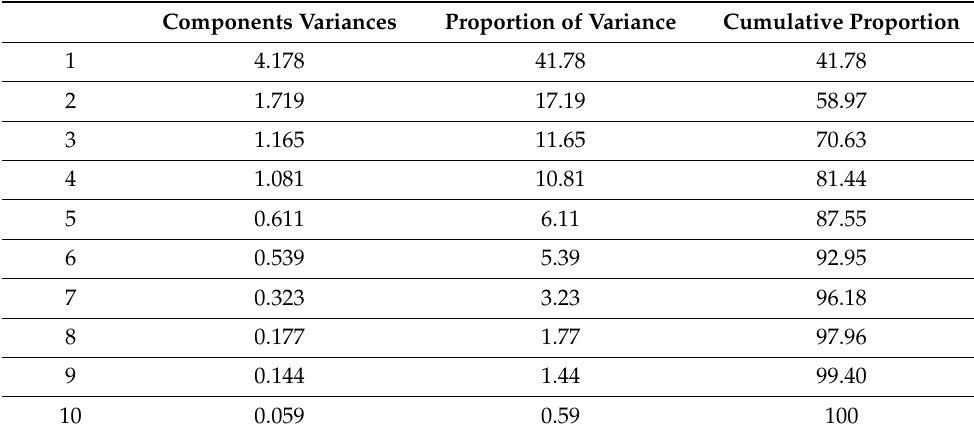
Table 3. Own values and proportion of variance explained by components.